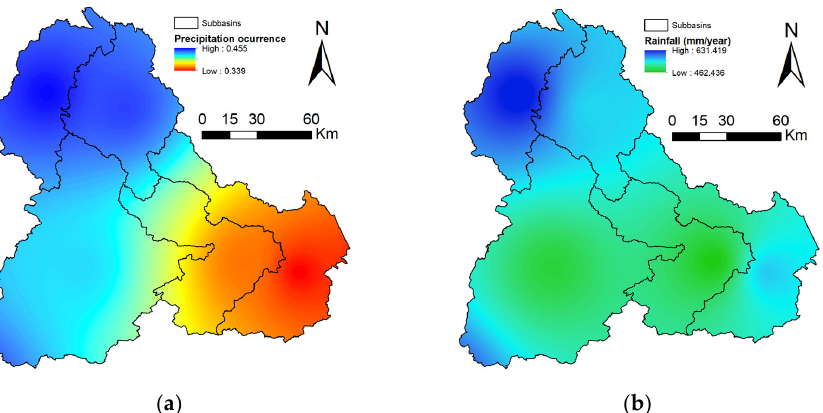
Figure A2. Spatial distribution of annual ( a ) precipitation occurrence (wet days/year) and ( b ) rainfall (mm/year).